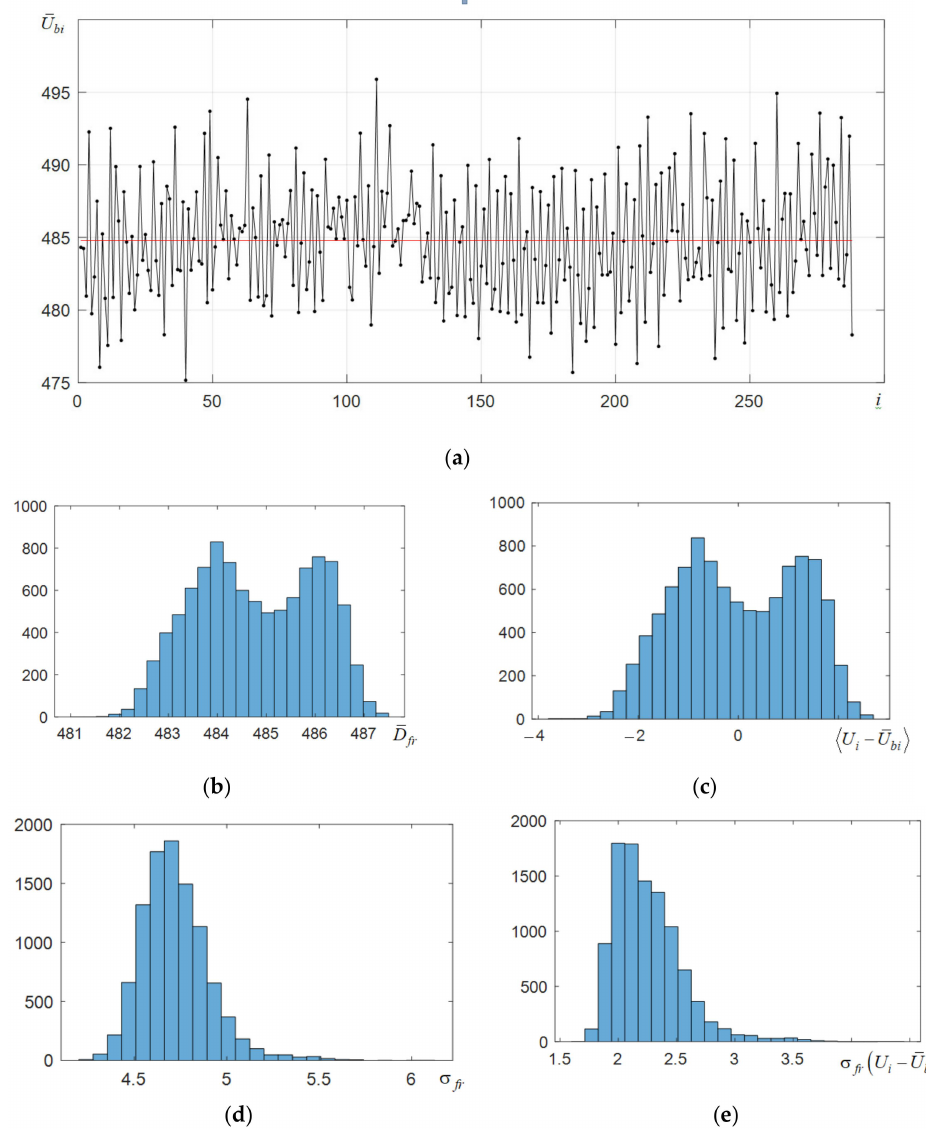
Figure 1. Dependence of the averaged (over 10,000 frames) dark counts on the number i of the photodiode array element of the microspectrometer C12880MA ( a ), histograms of distribution of mean values without ( b ) and after ( c ) subtracting the average baseline U bi , histograms of distribution of standard deviation without ( d ) and after ( e ) subtracting the average baseline U bi by